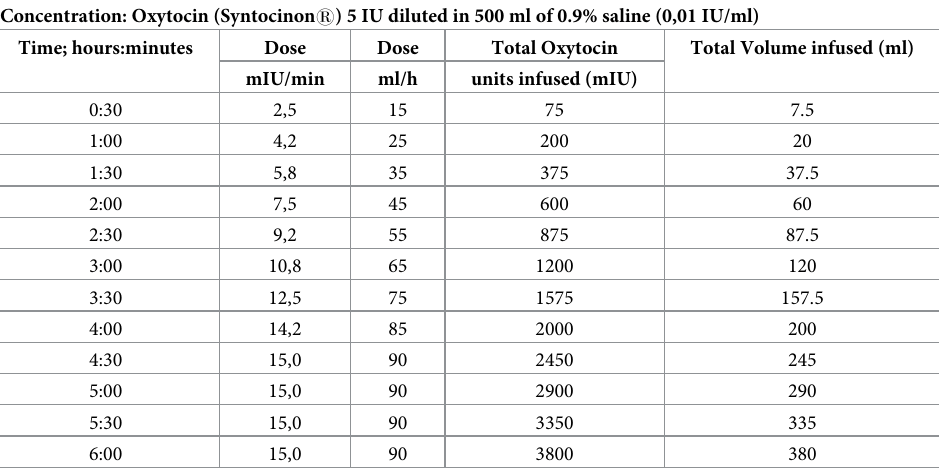
Table 1. The old intravenous low-dose oxytocin infusion